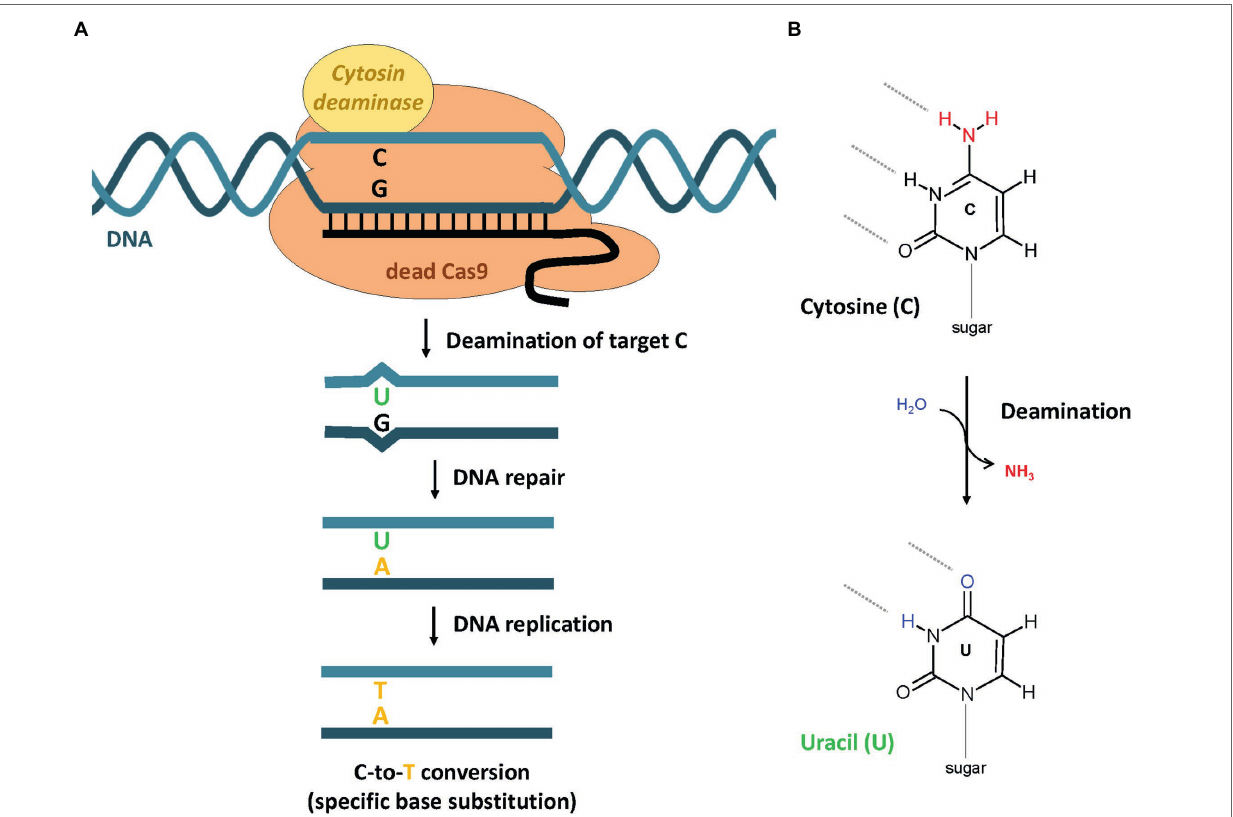
FIGURE 3 | Base editing by CRISPR-dependent cytosine base editor (CBE). (A) The CBE binds specifically to the target DNA, which is defined by the guide RNA sequence. (B) The fused cytosine deaminase catalyzes the deamination of the cytosine base, which results in the formation of uracil. Because of the changed base- pairing properties, the G-U pair forms a mismatch that is recognized by the DNA repair machinery of the cell. Repair events can result in the replacement of the original G to A. The C-to-T conversion becomes stable after